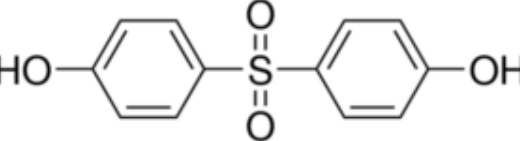
Figure 1. Chemical structure of bisphenol S.